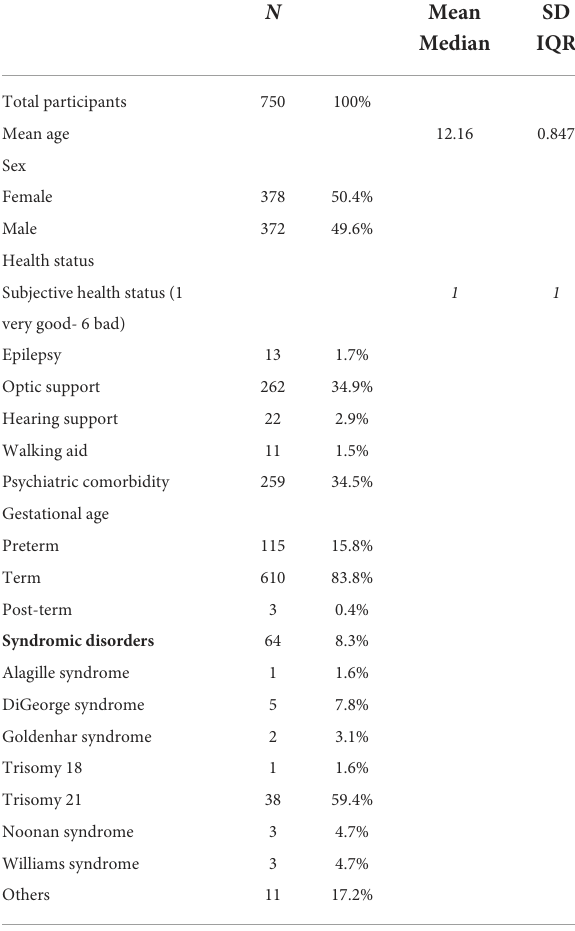
TABLE 1 Characteristics of all patients from our